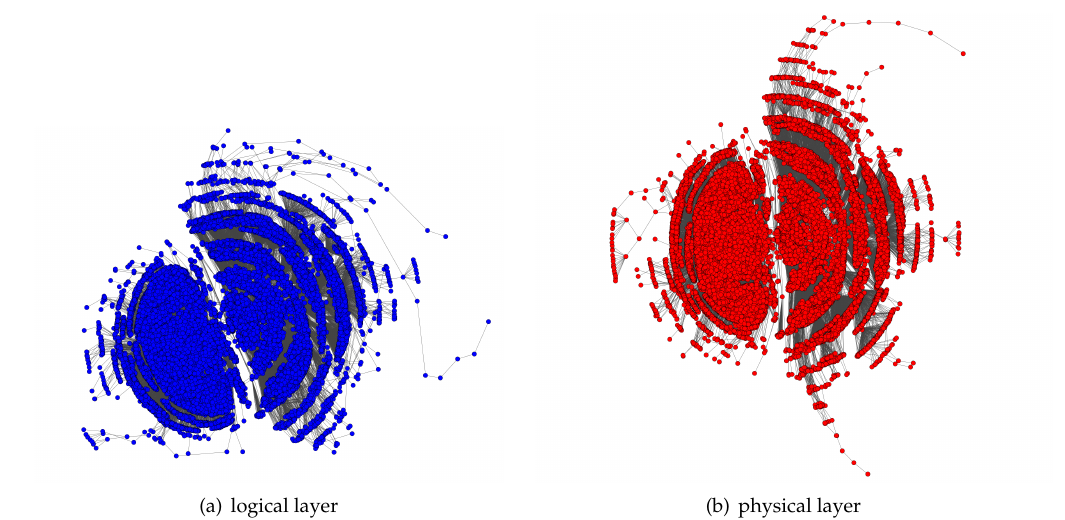
Figure 3. The structure of a real bi-layer IoT network (after data cleaning).